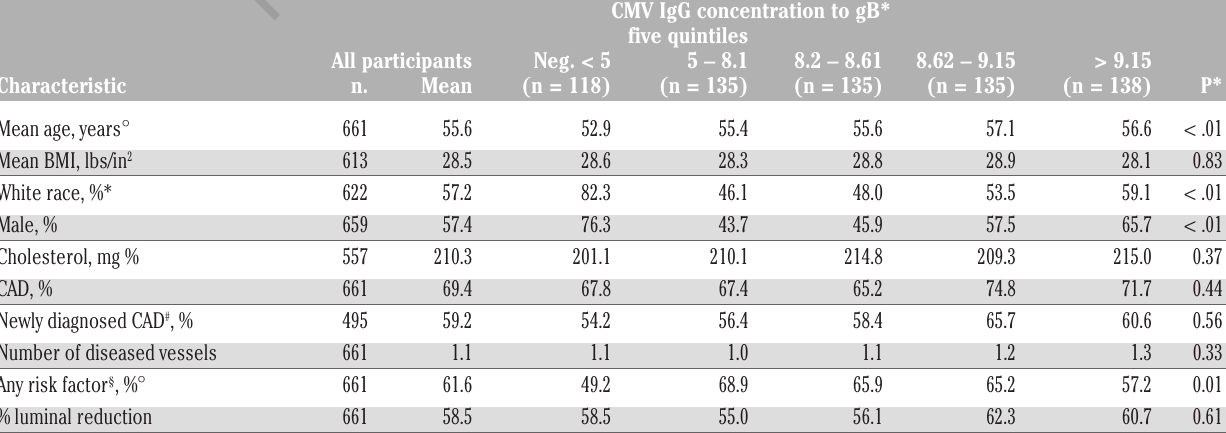
Table 2. Baseline characteristics of the study patients between 40 and 70 years of age using gB